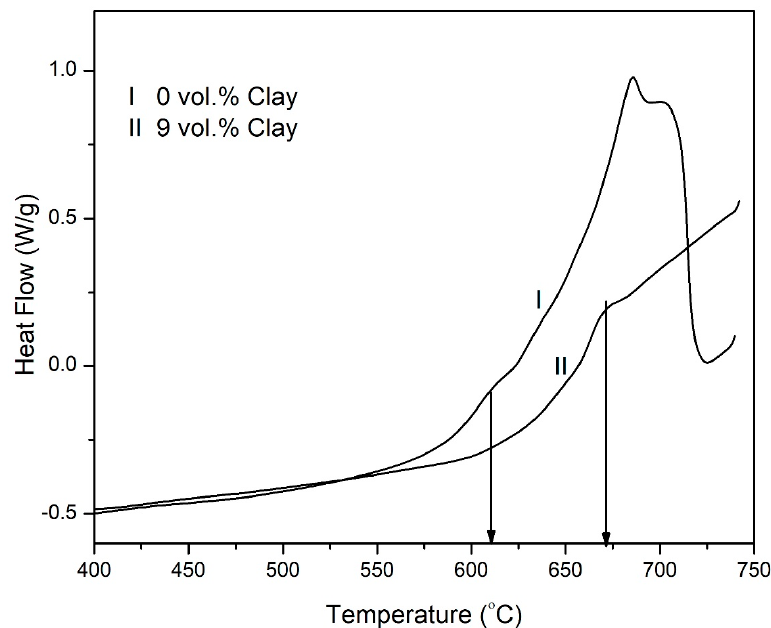
Figure 12. DSC thermograms for the hybrid composites, PI–NGS–Clay, containing, (I) 0 vol.% and (II) 9 vol.% clay in air atmosphere.